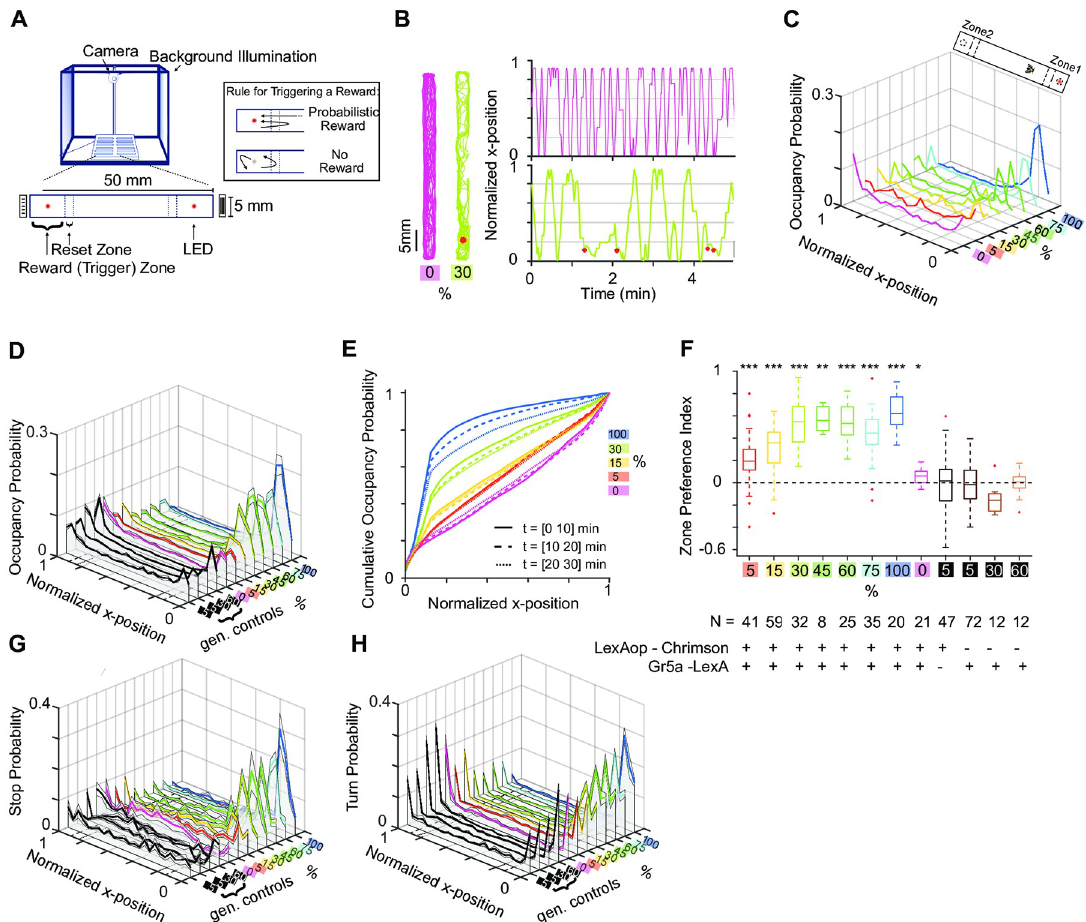
Fig 1. Place preference as a function of Gr5a -receptor-neuron stimulation. For optogenetic stimulation we used flies that express Chrimson in Gr5a neurons. As a genetic control we used LexAop-Chrimson /+ and Gr5a-LexA /+ flies. gen.controls for first 5% refers to LexAop-Chrimson /+ and 5%, 30%, 60% to Gr5a-LexA/ + genetic lines. A Single-fly optogenetic foraging set-up. A system of 12 linear track arenas is placed in a behavior box with uniform white background illumination and monitored by a webcam from above. Each arena contains two stimulating LEDs (= 624 nm) mounted below each of the track. Reset and trigger zones (short and long dash) are not visible to the flies. Distal visual cues were drawn behind each trigger zone: black and white stripe patterns with different orientations on each side. Inset: Rule for triggering a probabilistic flash of light. A flash is triggered only when the fly enters the reset and the reward zones in that order. B Left: Two dimensional walking traces of an unstimulated example fly (magenta) and 30% probability stimulated example fly (green). Light stimulation was delivered to only one side of the arena, marked with a red dot. Right: One dimensional walking trace over time of the same example fly. Stimulation events are marked with red dots. C Occupancy distribution of example individual from 0-100% stimulation conditions. D Occupancy distribution of fly populations that experienced the same stimulation probabilities as in C . Solid lines: Mean, shaded regions around mean: ± SEM. Genetic controls used as in F , LexAop-Chrimson /+ and Gr5a-LexA /+ do not express Chrimson. E Cumulative occupancy distribution over 10 minute intervals across time. Higher stimulation probability leads to a decrease of zone preference over time. F Zone preference index of stimulated fly populations and genetic controls ( LexAop-Chrimson /+ and Gr5a-LexA /+) are shown as box plots (median, quartiles, entire range and outliers). Equal zone preference at preference index value 0 marked with black dashed line. Positive values indicate preference for zone 1 (stimulated) and negative values for zone 2. Stimulated flies have a significant zone preference of the stimulated zone over the unstimulated zone. ( � : p < 0.05; �� : p < 0.01; ��� : p < 0.001, Kruskal-Wallis test with multiple comparisons). G Stop distribution in the arena for the fly populations. Solid lines: Mean, shaded regions around mean: ± SEM. LexAop-Chrimson /+ and Gr5a-LexA /+ were used as genetic controls. For definitions of stops and turns refer to materials and methods H Turning distribution for the fly populations. Solid lines: Mean, shaded regions around mean: ± SEM. LexAop-Chrimson /+ and Gr5a-LexA /+ were used as genetic controls.